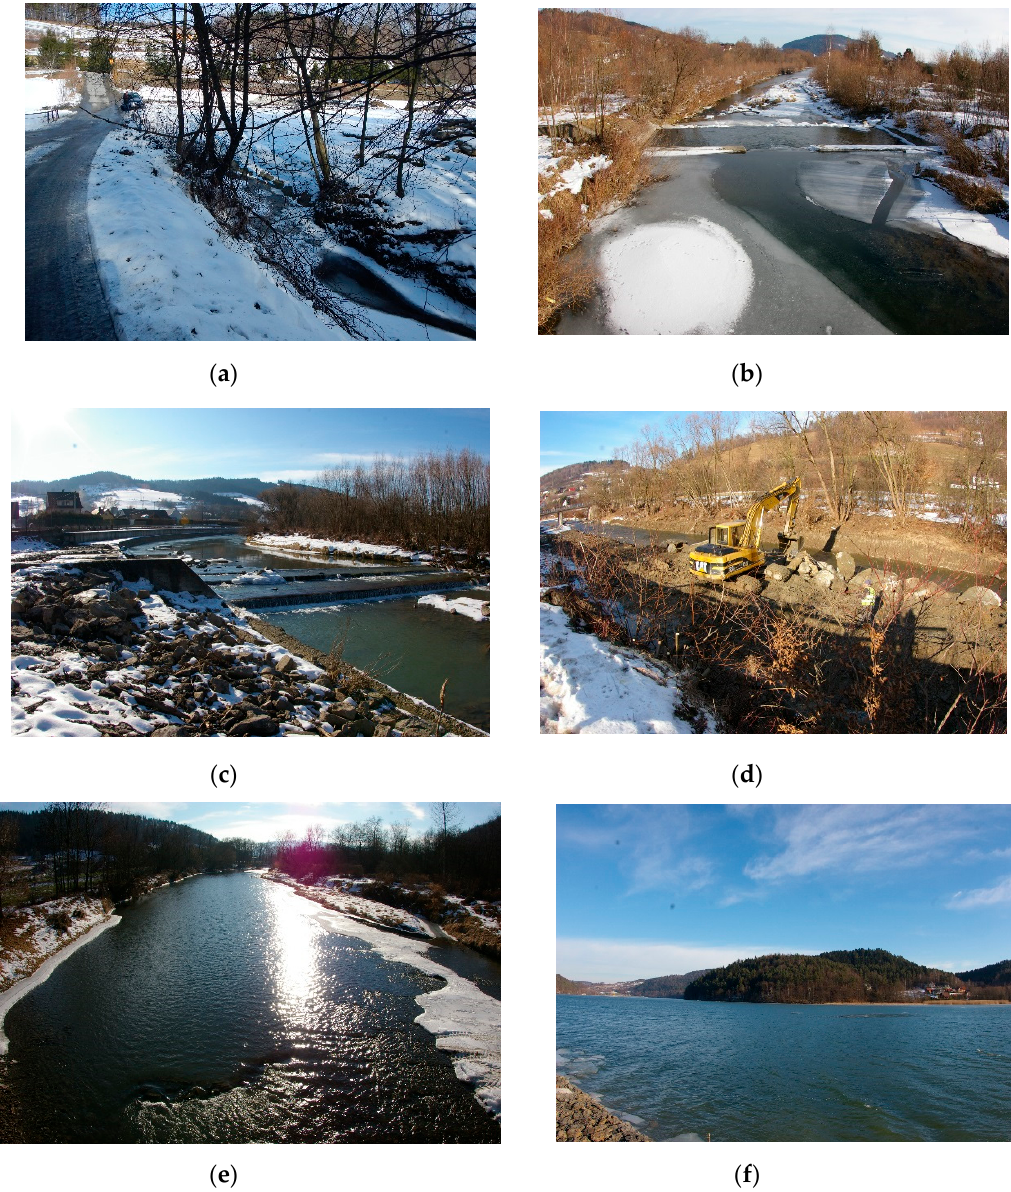
Figure 5. The Lososina River—different cross sections along the river reach. ( a ) source part in Dobra; ( b ) engineered part in Podplomien; ( c ) engineered part in Tymbark; ( d ) river training works in Laskowa; ( e ) natural part in Lososina ; ( f ) water reservoir